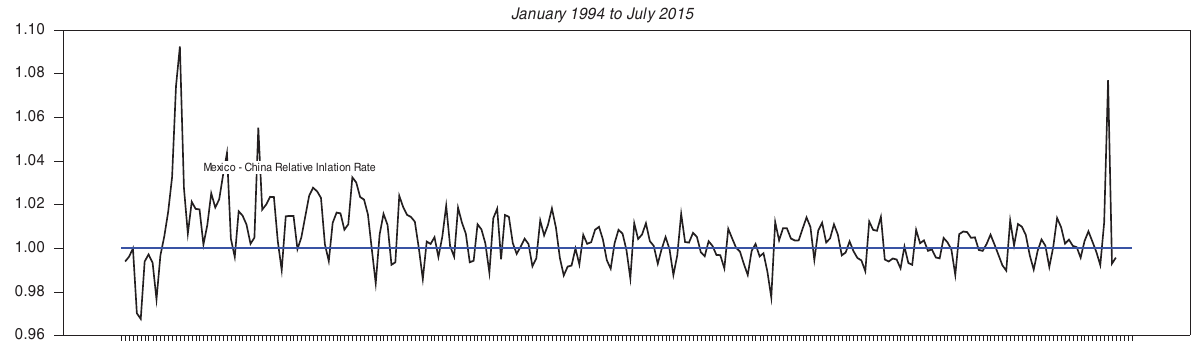
Fig. 2. Mexico’s inflation rate relative to U.S.’ s inflation rate